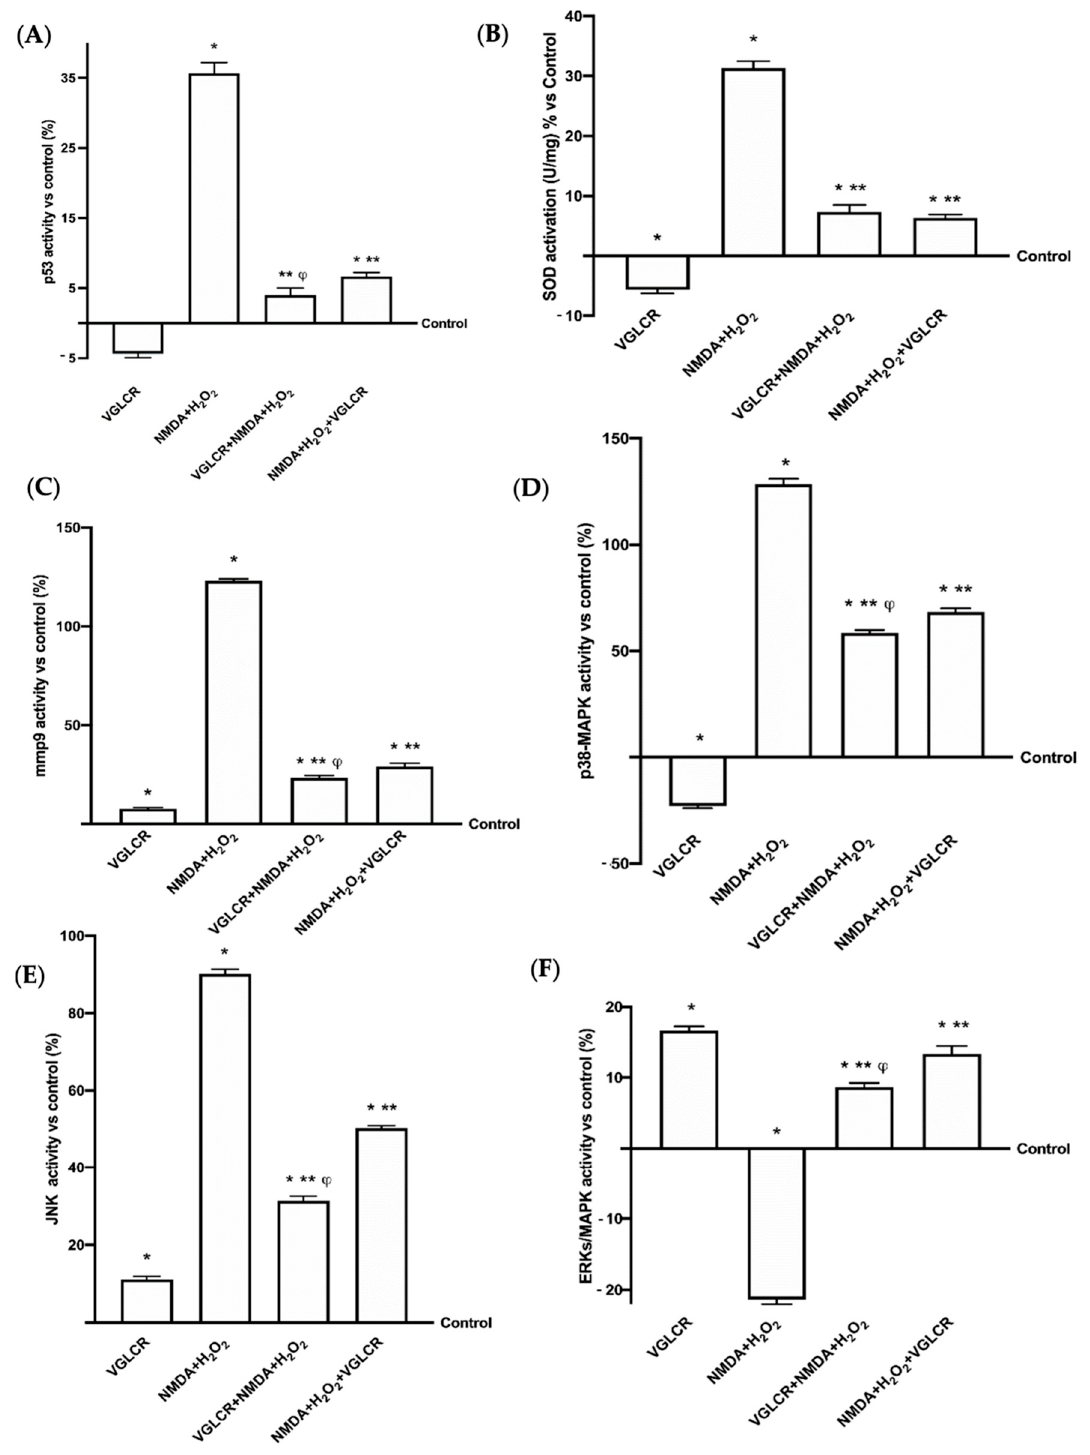
Figure 6. Activity assays of the main markers involved in glaucoma. In ( A ) p53, in ( B ) SOD, in ( C ) MMP9, in ( D ) p38/MAPK, in € Jnk1/2, in ( F ) ERKs/MAPK. Retinal tissues were treated with NMDA and H 2 O 2 added together, and before and after VGLCR stimulations. The results are expressed as means ± SD (%) vs. control of 4 independent experiments, reproduced in duplicates. * p < 0.05 vs. control; ** p < 0.05 vs. NMA + H 2 O 2 ; φ p < 0.05 vs. NMA + H 2 O 2 + VGLCR. The abbreviations are the same as used in Figure 1.